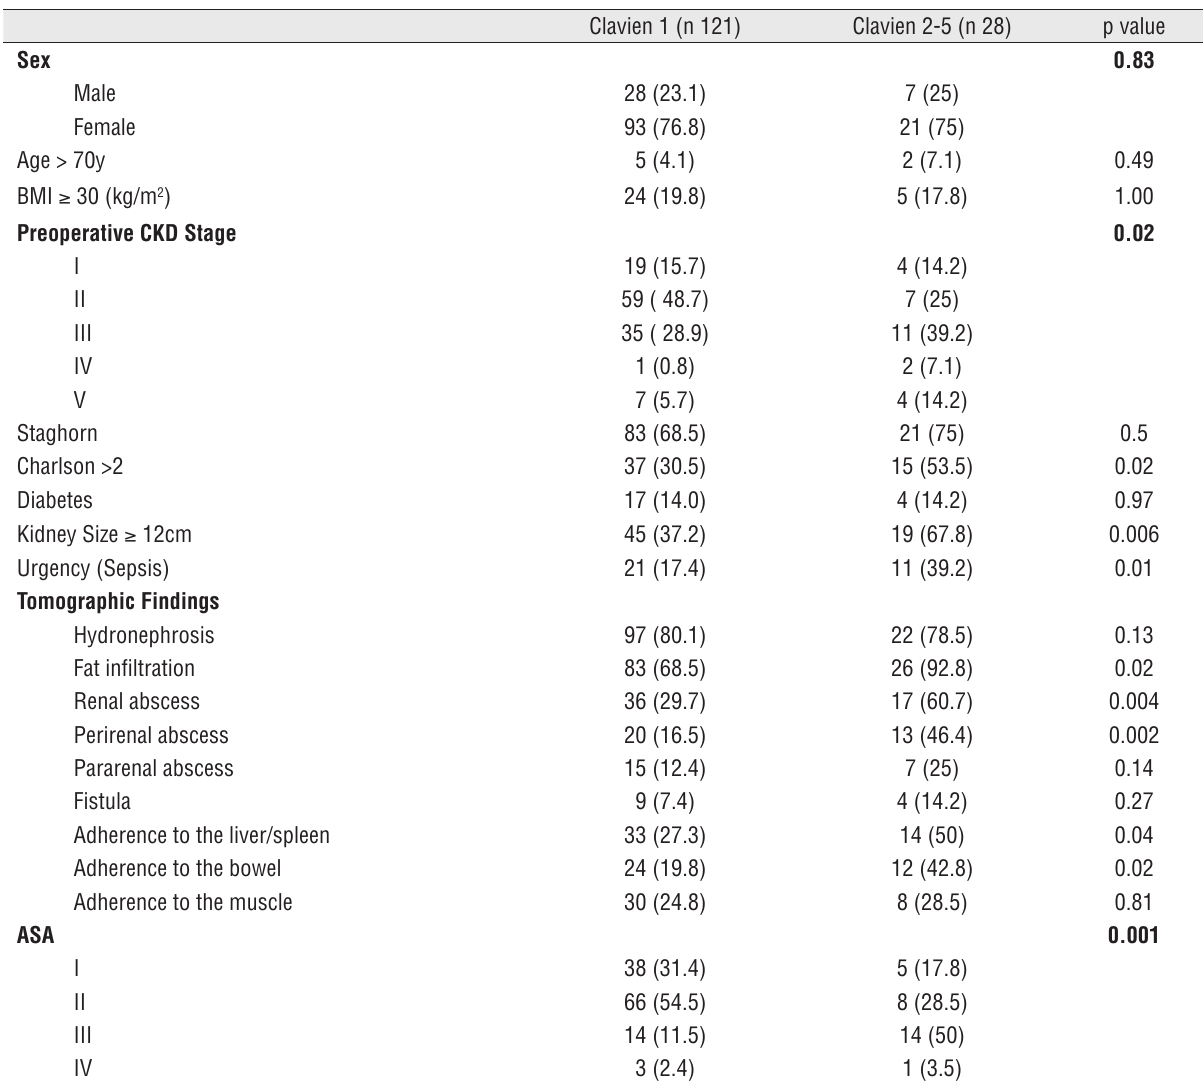
Table 3 - Univariable analysis of risk factors for clavien > 1 in nephrectomy for urolithiasis.